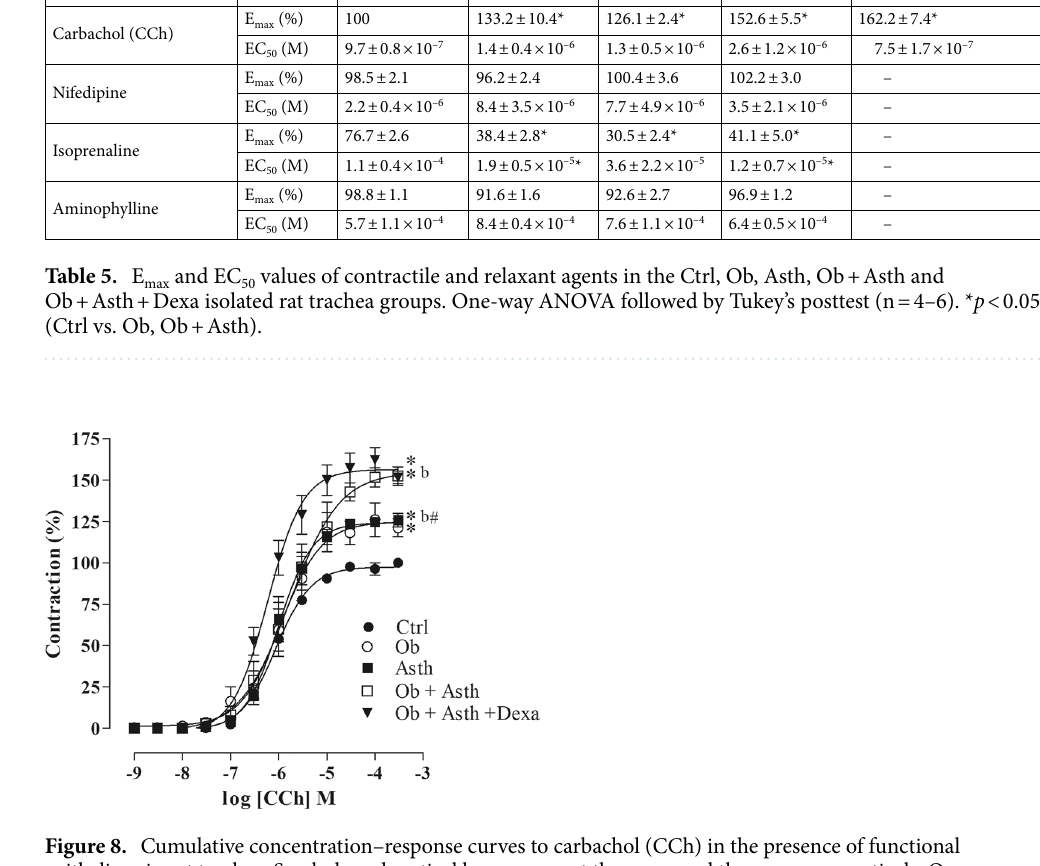
Figure 8. Cumulative concentration–response curves to carbachol (CCh) in the presence of functional epithelium in rat trachea. Symbols and vertical bars represent the mean and the e.p.m., respectively. One-way ANOVA followed by Tukey’s posttest (n = 5). * p < 0.05 (Ctrl vs. Asth, Ob, Ob + Asth and Ob + Asth + Dexa); b p < 0,05 (Asth vs. Ob +